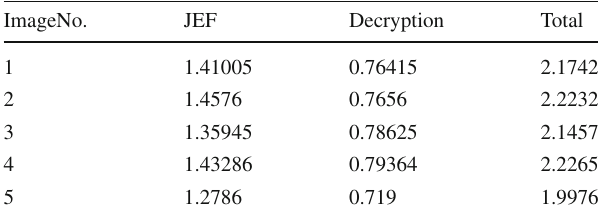
Table 4 Time efficiency(s)